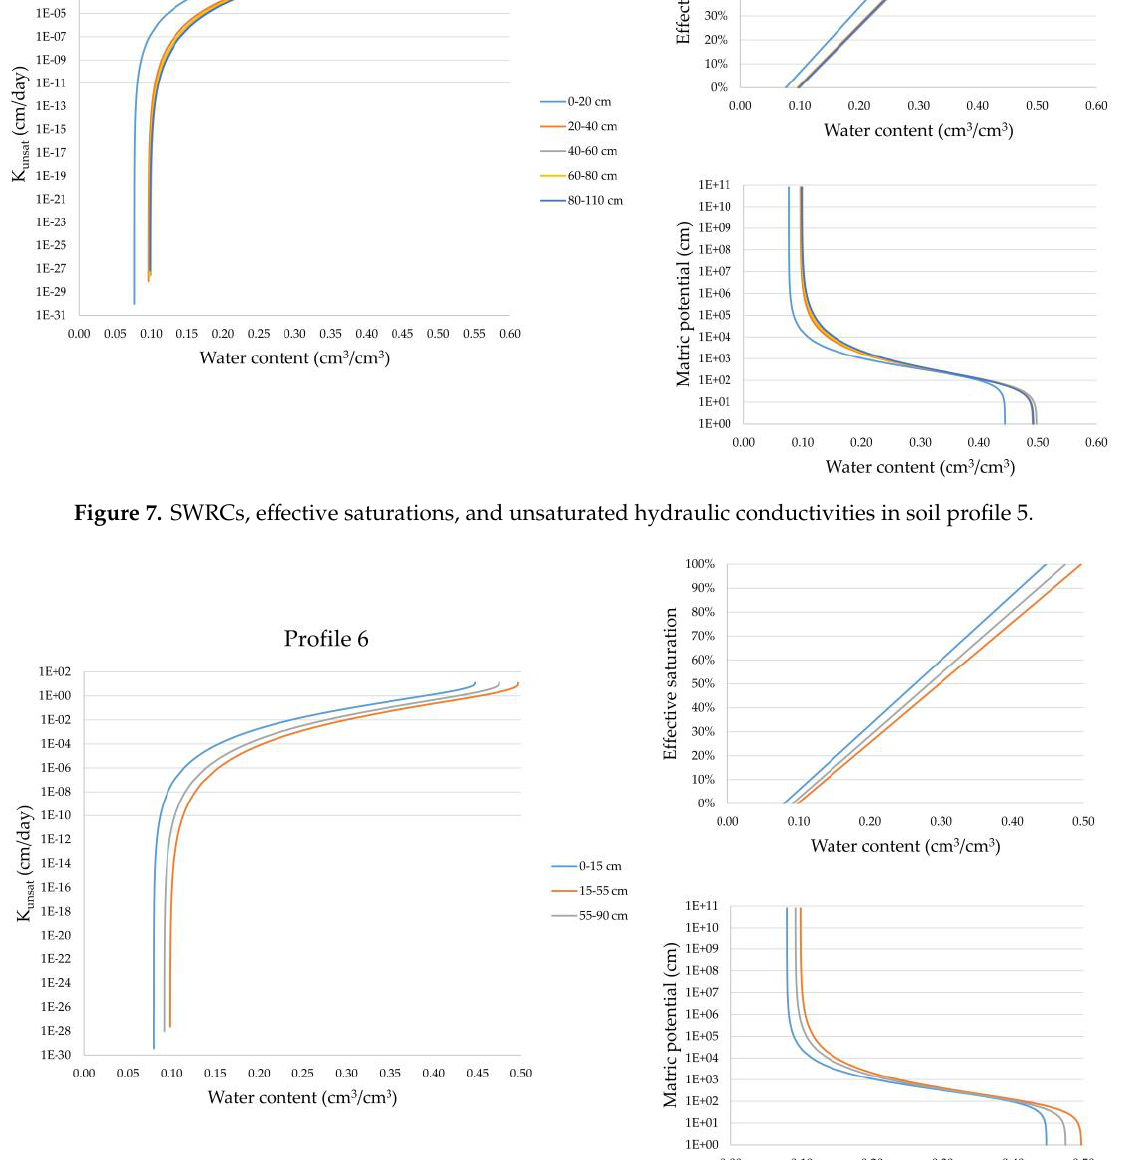
Figure 8. SWRCs, e ff ective saturations, and unsaturated hydraulic conductivities in soil profile Figure 8. SWRCs, effective saturations, and unsaturated hydraulic conductivities in soil profile 6.